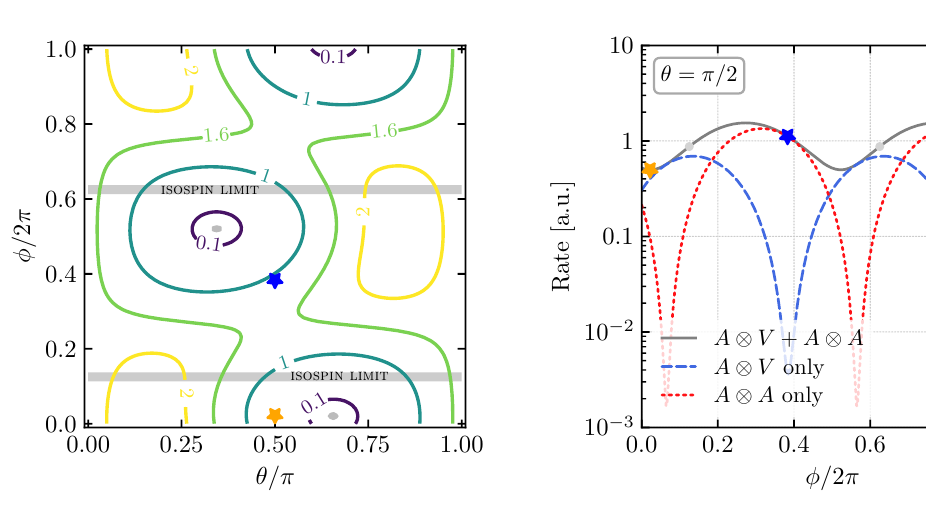
(b) Relative event rate along θ = π/ 2 corre- sponding to C (6) = 0 . 6 , 1